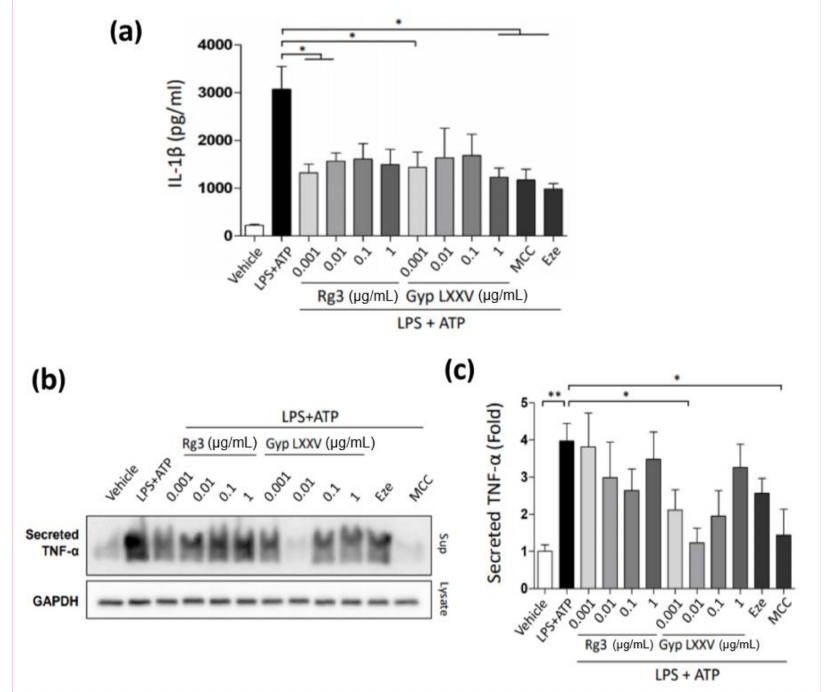
Figure 2. Inhibition e ff ect of Gyp LXXV on inflammation using macrophage-induced THP-1 cells. Attenuated secretion level of IL-1 β ( a ) or TNF- α ( b , c ) for Gyp LXXV or Rg3 at various concentration (0.001–1 µ g / mL). THP-1 cells were stimulated with lipopolysaccharide (LPS) (0.1 µ g / mL) and ATP (2 mM). * p < 0.05 vs. LPS + ATP group. MCC (10 nM) or ezetimibe (Eze; 50 µ M) was used as a positive